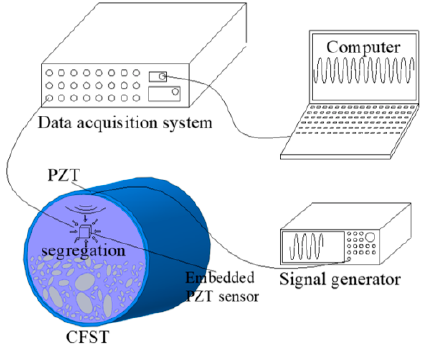
Figure 1. Aggregate segregation detection method for concrete core in circular concrete-filled steel tubulars (CCFST) members using piezoelectric lead zirconate titanate (PZT)